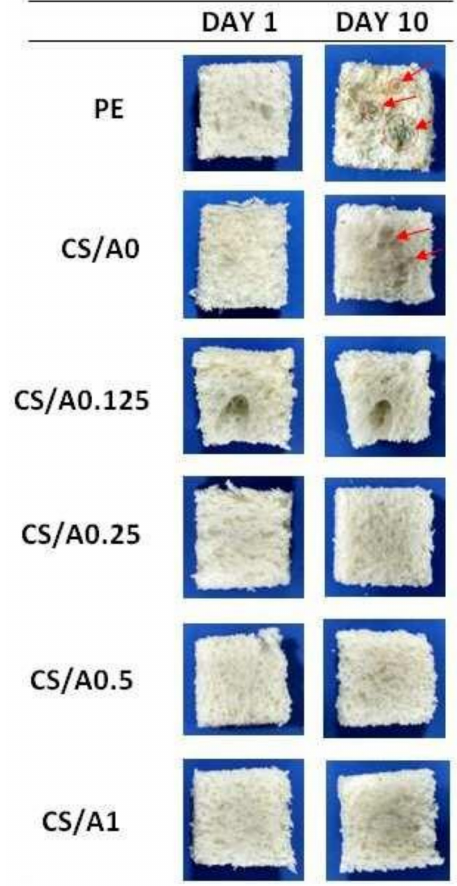
Figure 23. Inhibition of fungal growth on bread pieces packed in modified chitosan films (fun- gal growth is indicated in red arrows). Reprinted from [69]. Copyright 2018 with permission from